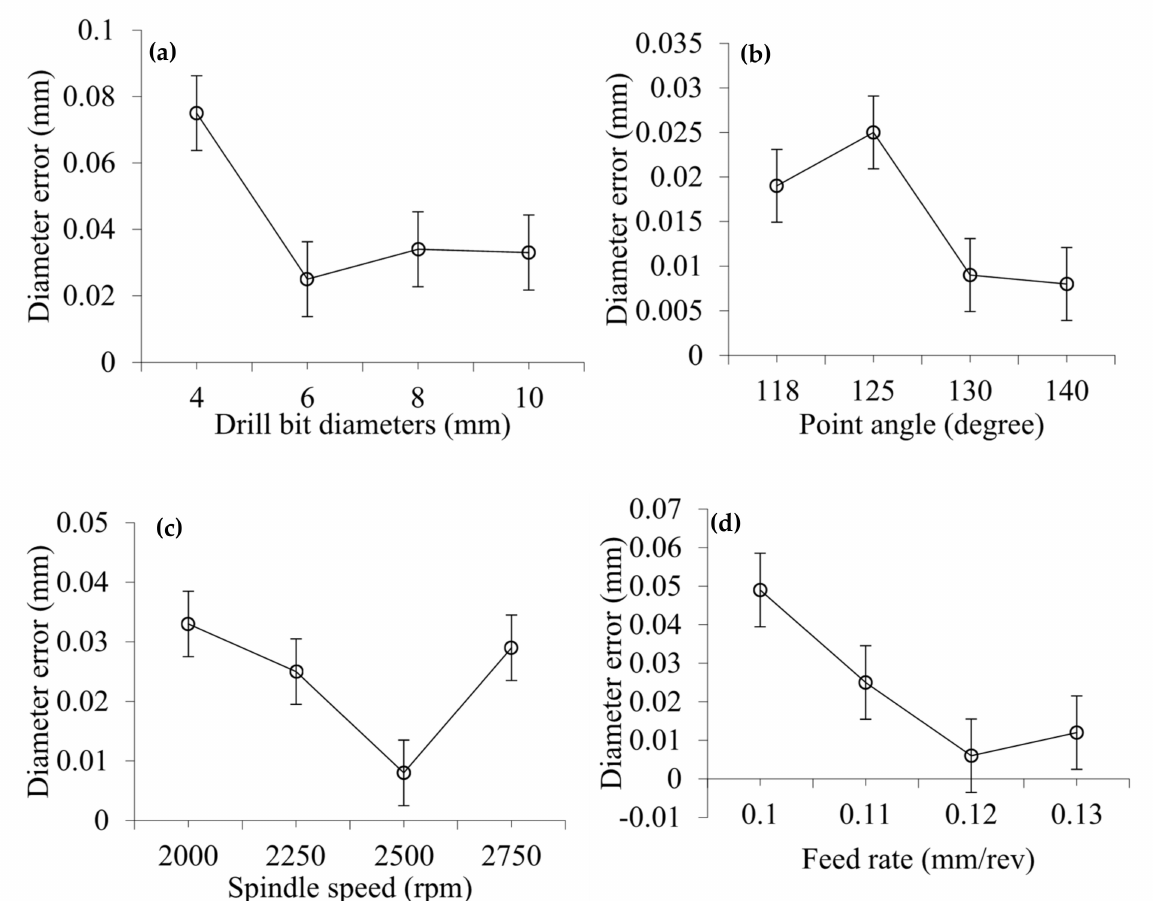
Figure 8. ( a , b ) Effect of drill bit diameter (at point angle 125 ◦ ) and point angle (at drill bit diameter 6 mm) on diameter error with 6 Scotch tape layers at spindle speed of 2250 rpm, and feed rate of 0.11 mm/rev, ( c , d ) Effect of spindle speed (at feed rate 0.11 mm/rev), and feed rate (at spindle speed 2250 rpm) on diameter error at drill bit diameter of 6 mm, point angle of 125 ◦ with 6 Scotch tape layers.